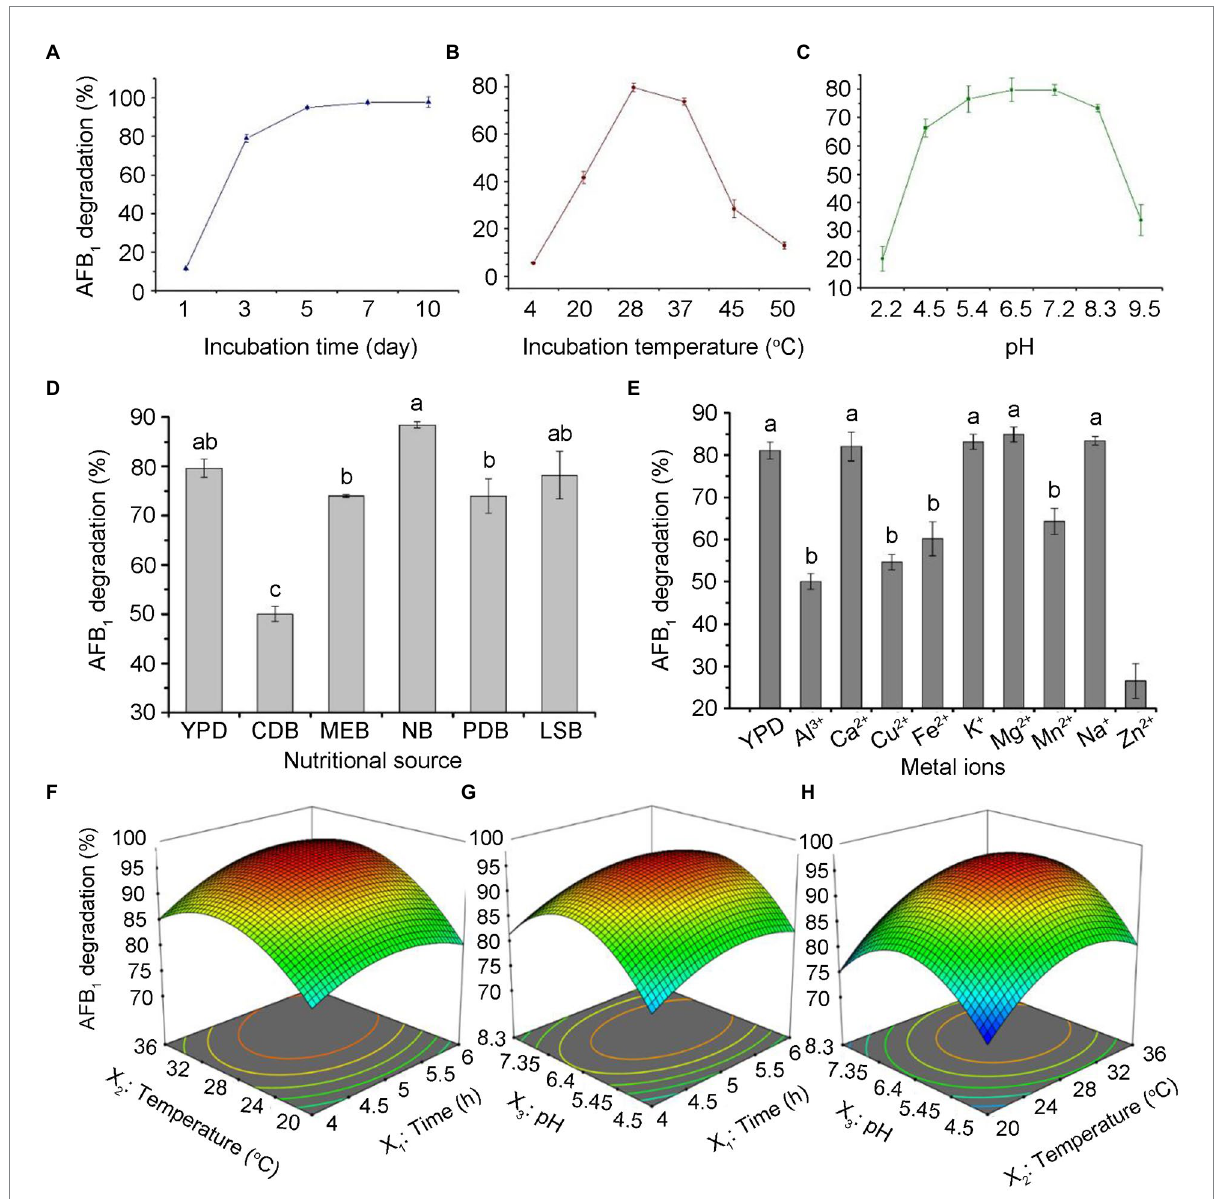
FIGURE 4 Optimizing culture conditions for CGMCC3.5218 to remove aflatoxins. Effect of (A) incubation time, (B) culture temperature, (C) pH, (D) nutritional sources, and (E) metal ions on the degradation of 500 ng/kg aflatoxin B 1 (AFB 1 ) by T. reesei CGMCC3.5218. Response plots between